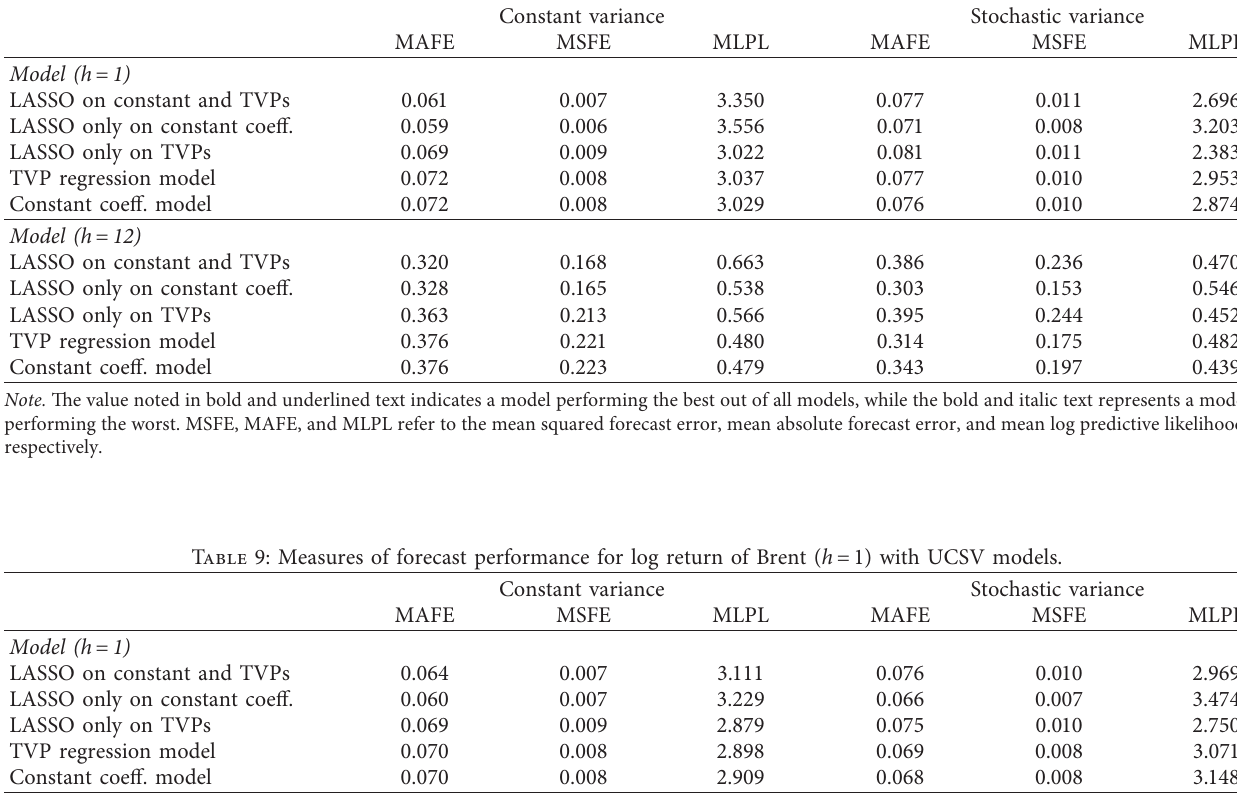
Table 8: Measures of forecast performance for log return of Brent with multivariate models.